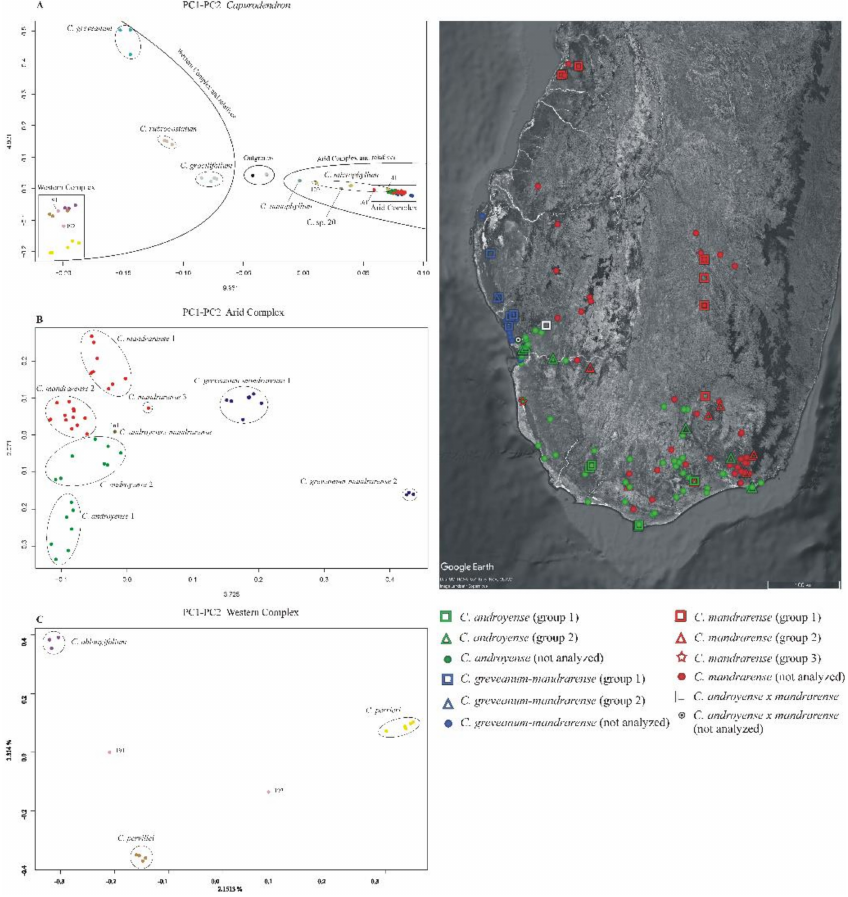
Figure 5. Principal Components Analysis (PCA) of 227 microsatellite flanking regions of ( A ) the complete dataset, ( B ) the Arid Species Complex, and ( C ) the Western Species Complex. The distribu- tion map of the samples of the Arid Complex is shown on the righ side. Specimens 120 and 41 here included under Capurodendron microphyllum , share some morphological characters with C. androyense